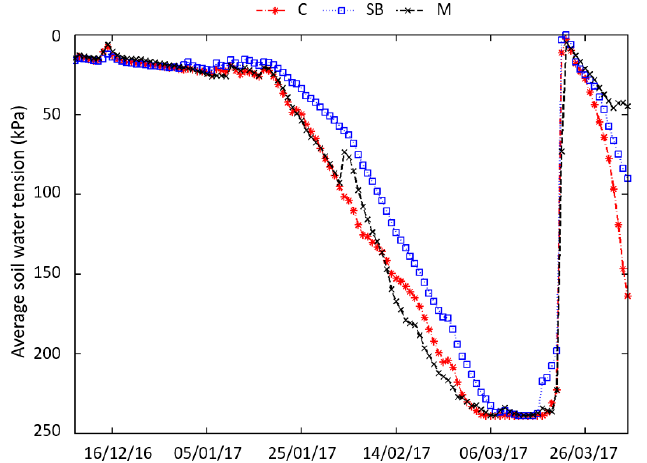
Figure 4. Average soil water tension for the amendment treatments in the 2016/17 dry season: (C) no soil amendment, (SB) rice straw at 5 t ha − 1 buried in beds as a part of bed forming and (M) surface spread cow and goat manure at 20 t ha − 1 before bed forming.